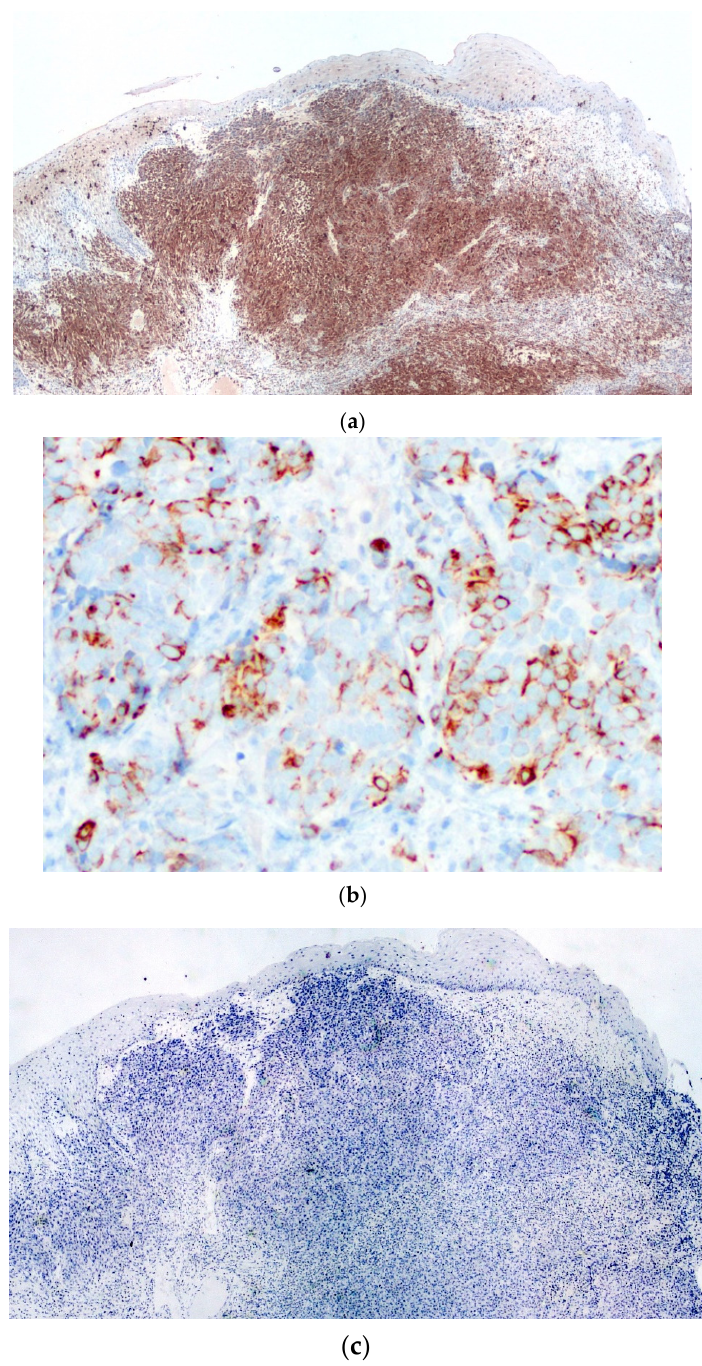
Figure 6. The neoplastic cells are strongly and diffusely immunoreactive for S-100 protein ( a ) (×2) and cytokeratins (with a dot-like pattern) ( b ) (×20), but negative for HMB-45 ( c ) (×2) as well as for Melan-A (not shown).